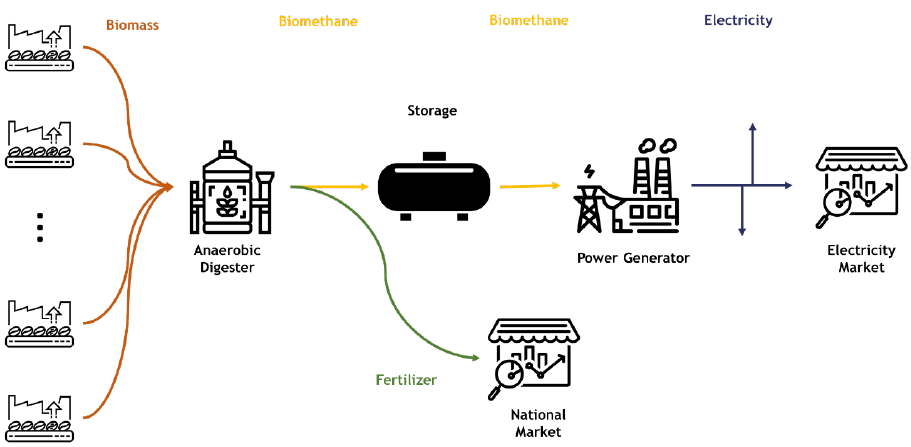
Figure 4. Structure of the “exploiting biomass” proposed implemen